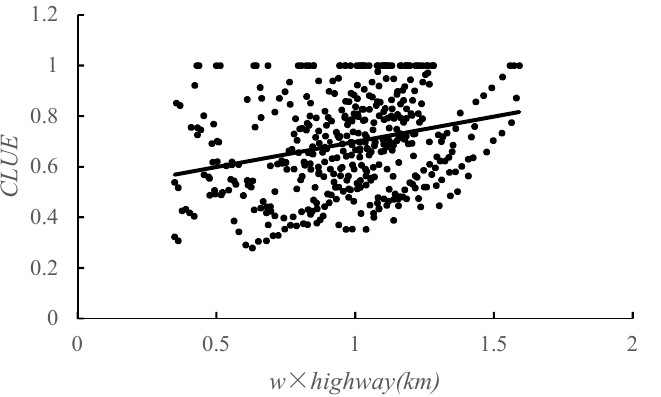
Figure 5. Scatter diagram of the linear fitting between the spatial lag of highway density and CLUE.